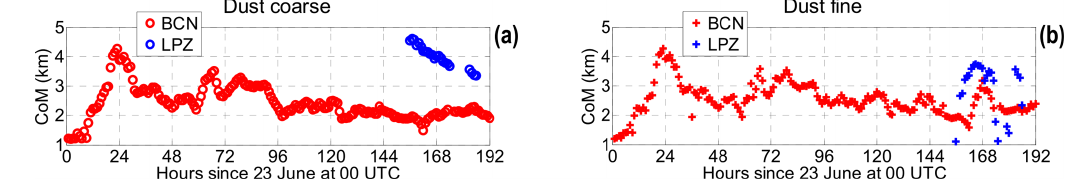
Figure 5. Hourly dust layer center of mass (CoM) for (a) the coarse mode and (b) the fine mode in BCN (red) and LPZ (blue).